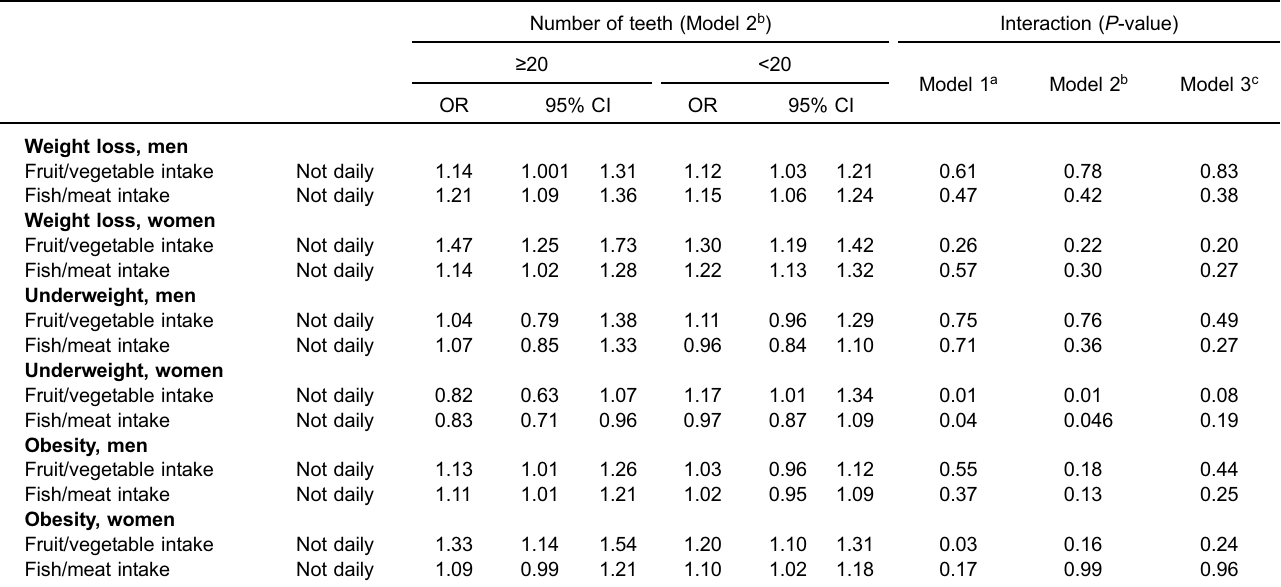
Table 4. Interaction between frequency of food intake and number of teeth in relation to weight loss, underweight, and obesity Number of teeth (Model 2 b